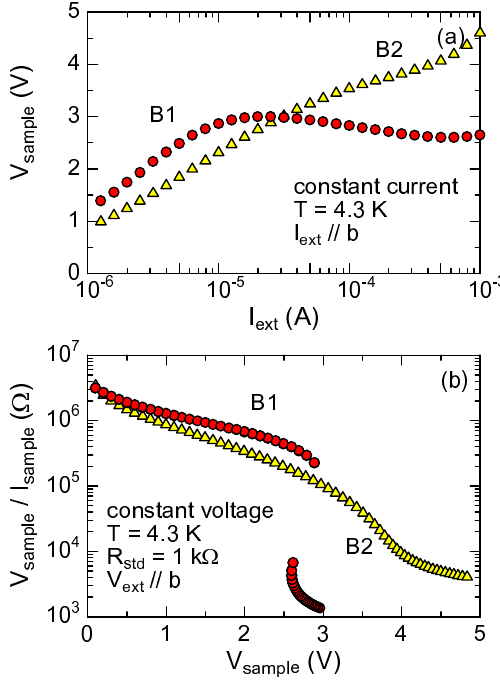
Figure 1 . (a) Voltage-current characteristics of Samples B1 and B2 measured in constant /I currents at 4.3 K. (b) Resistance V of Sample B1 and B2 plotted as a function sample sample of the sample voltages V measured in constant voltage at 4.3 sample